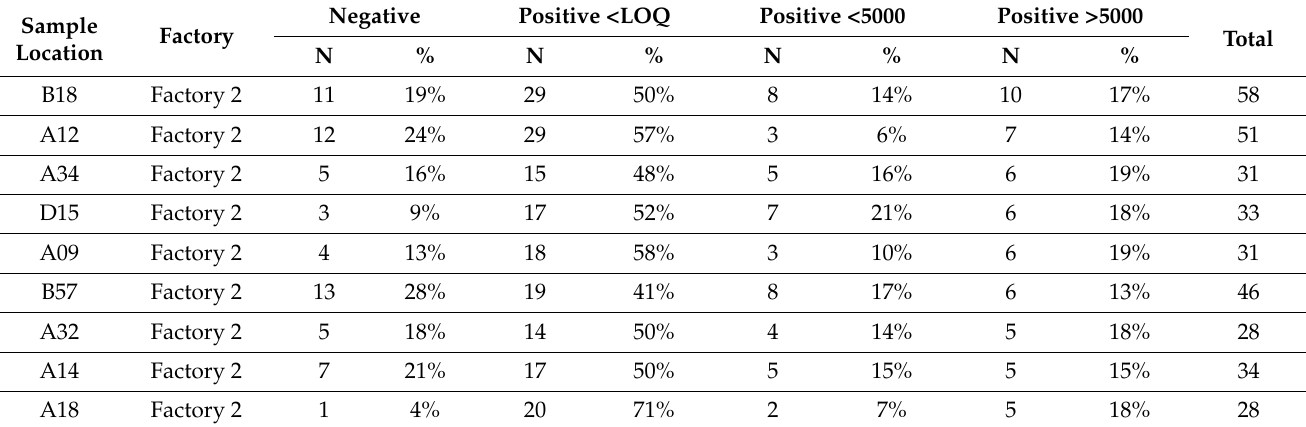
Table 1. Sample points where greater than five samples recorded >5000 genomic units (GU)/L Legionella spp.